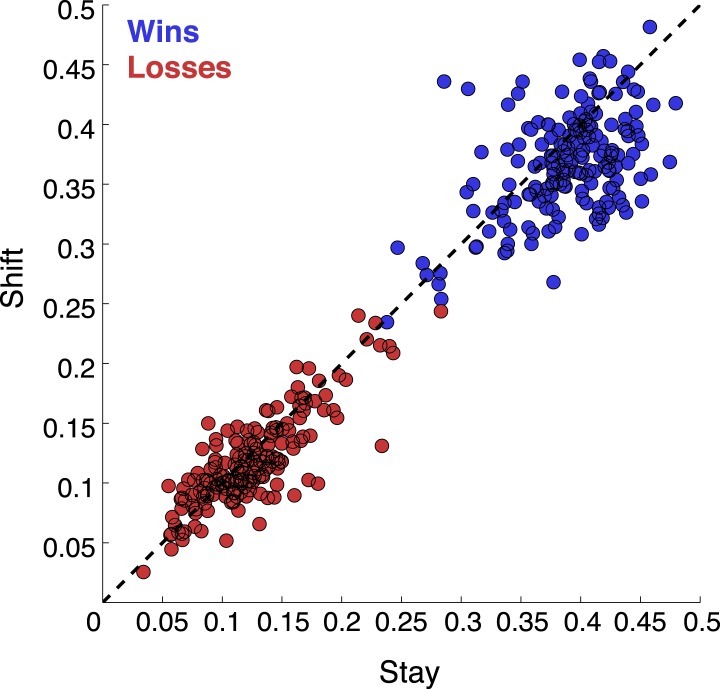
No evidence for Win-Stay, Loose-Shift strategy.